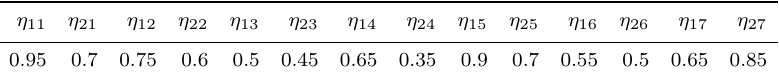
Table 7. Values of